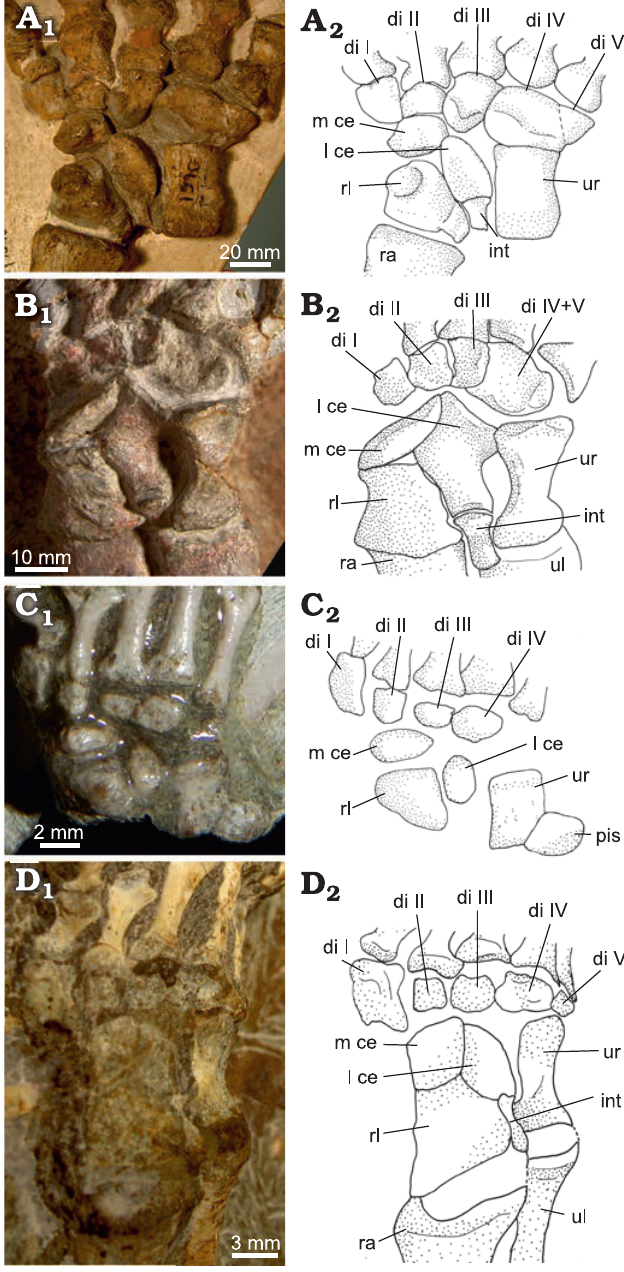
Fig. 6. Carpus of Gorgonopsia and Therocephalia. A . Gorgonopsia indet. BP/1/1210, Hoeksplaas, Murraysburg, South Africa, Daptocephalus Assem- blage Zone, Changhsingian, left carpus (reversed), dorsal view. B . Basal